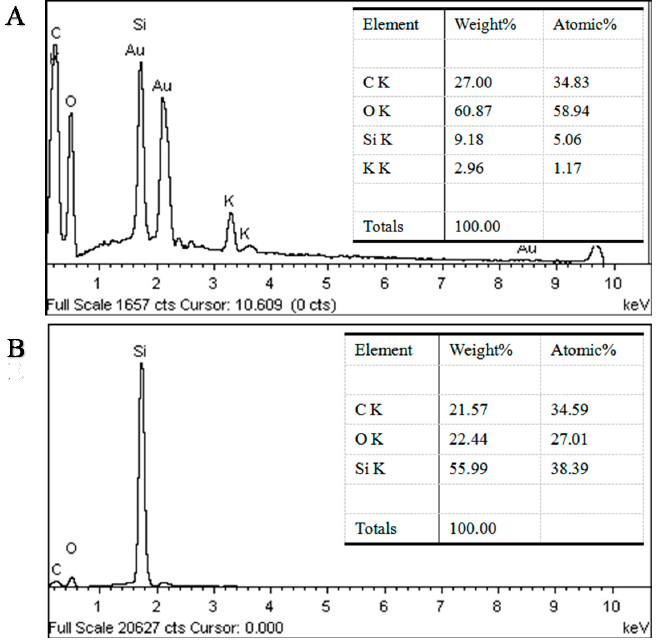
Figure 9. The EDS analysis of wood samples on cross section ( A ) untreated wood and ( B ) PDMS@wood.